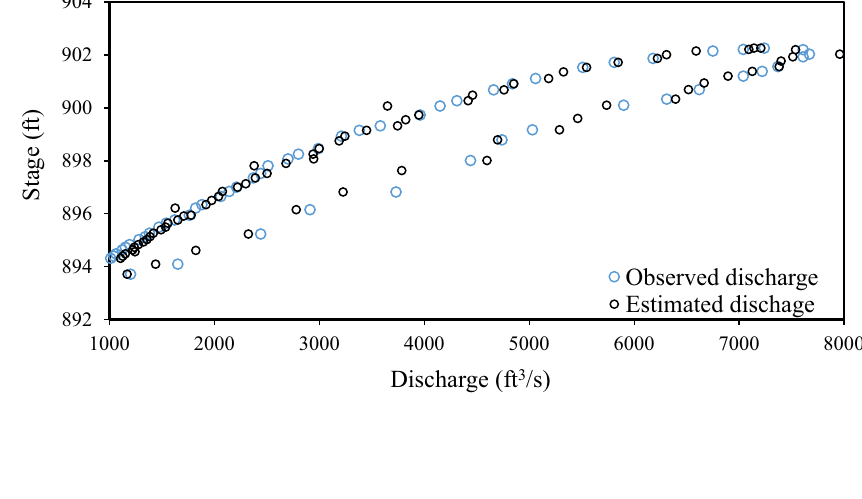
Fig. 2 Tracing the looped rating curve of Georgia Highway 141 using